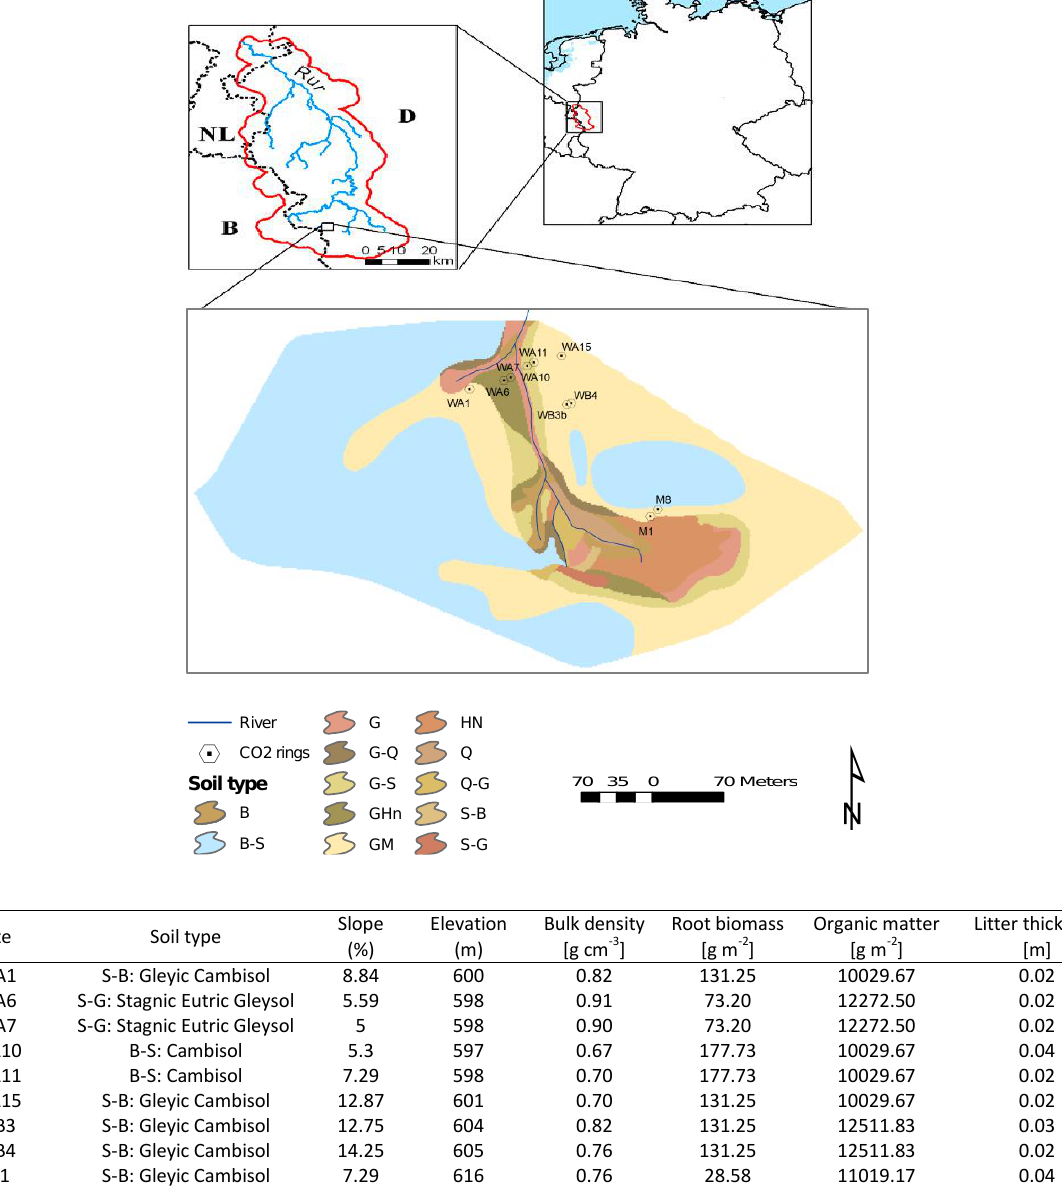
formation for the model was taken from a soil map (1 : 5000; Fig. 1) produced by the Geologischer Dienst NRW and from literature (AG Bodenkunde,